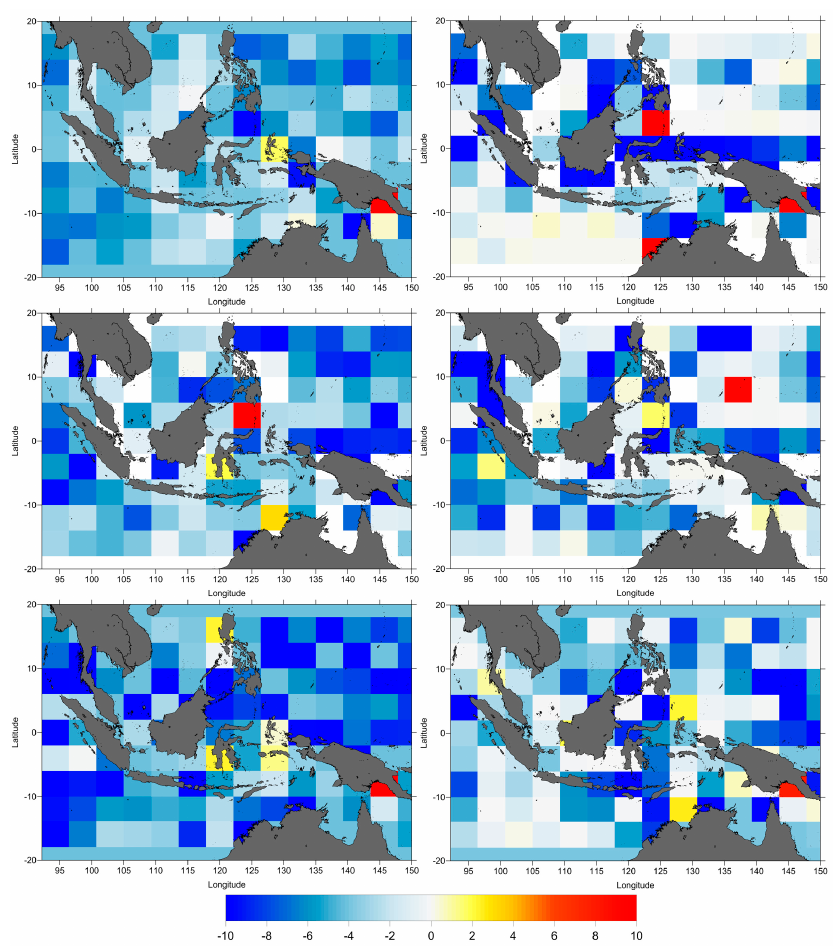
Figure 6. SLA variance differences of WTC, function of distance from coast, GPD+ − ERA (orange) and GPD+ − MWR (blue), for TOPEX/Poseidon cycles 1 to 364, Jason-1 cycles 1 to 259 and Jason-2 cycles 1 to 280 .